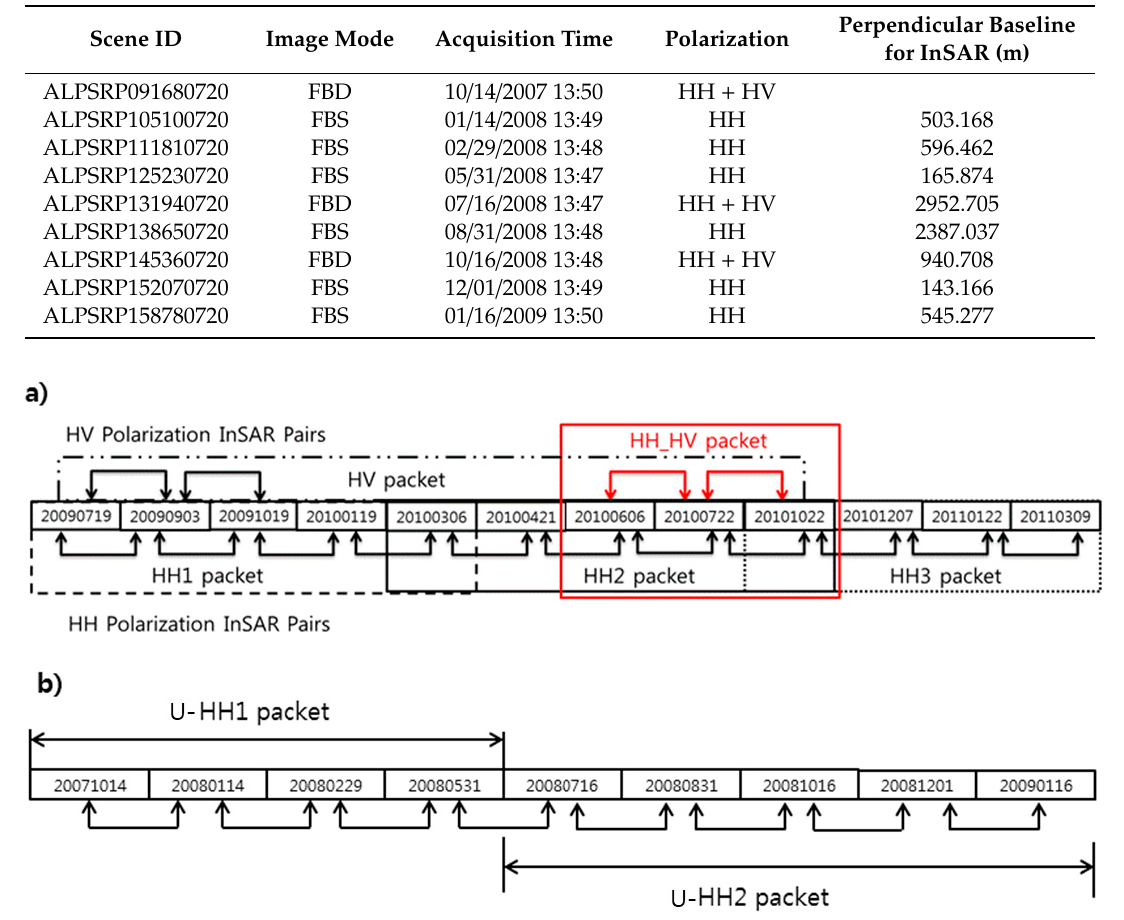
Figure 1. Employed InSAR time sequence pairs and the packet compositions in Mt. Baekdu ( a ) and Uljin ( b ).